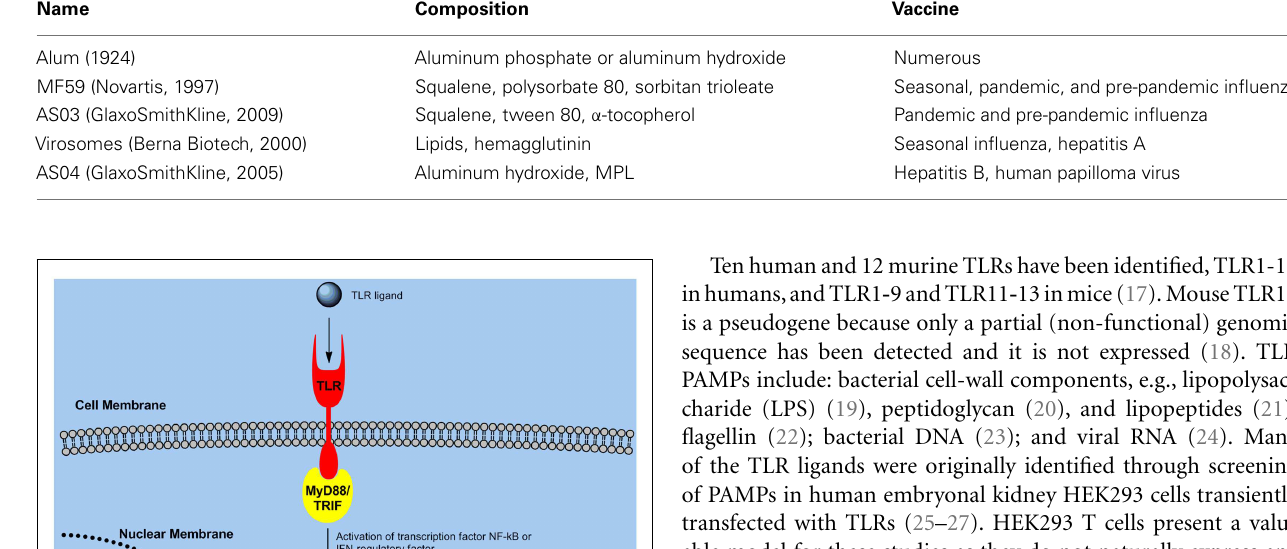
FIGURE 4 |Toll-like receptor signaling pathway: recognition of pathogens throughTLR ultimately triggers signaling through the NF- κ B pathway, consequently leading to gene activation and production of pro-inflammatory cytokines/chemokines .